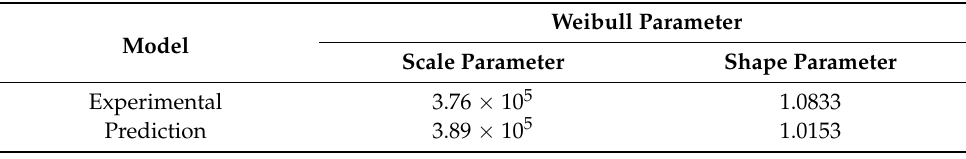
Table 6. Scale and shape parameter of the Weibull distribution.